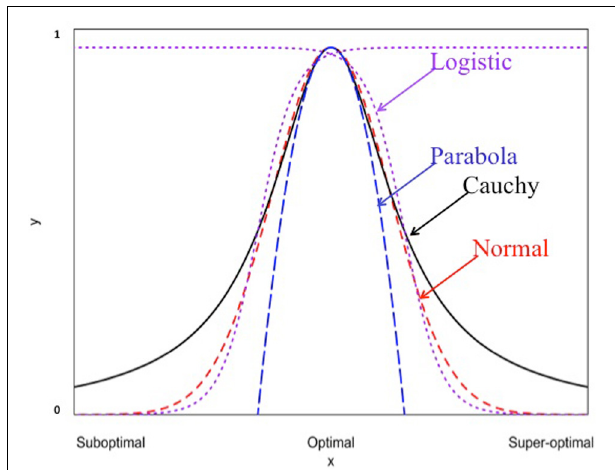
FIGURE 1 | Four different non-linear functions for studying genotype-environment interaction (normal, Cauchy, parabola, and